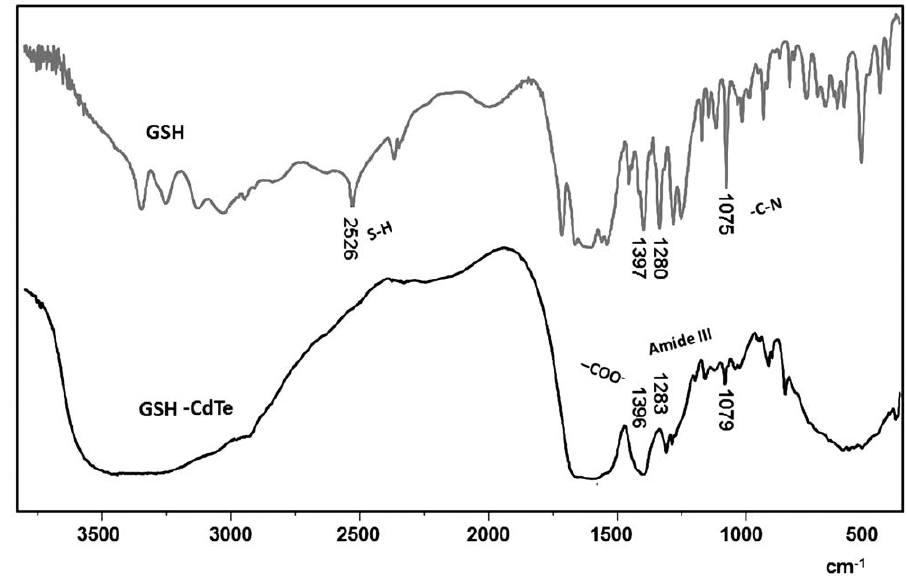
Figure 2. IR spectra of CdTe-GSH NPs and GSH.